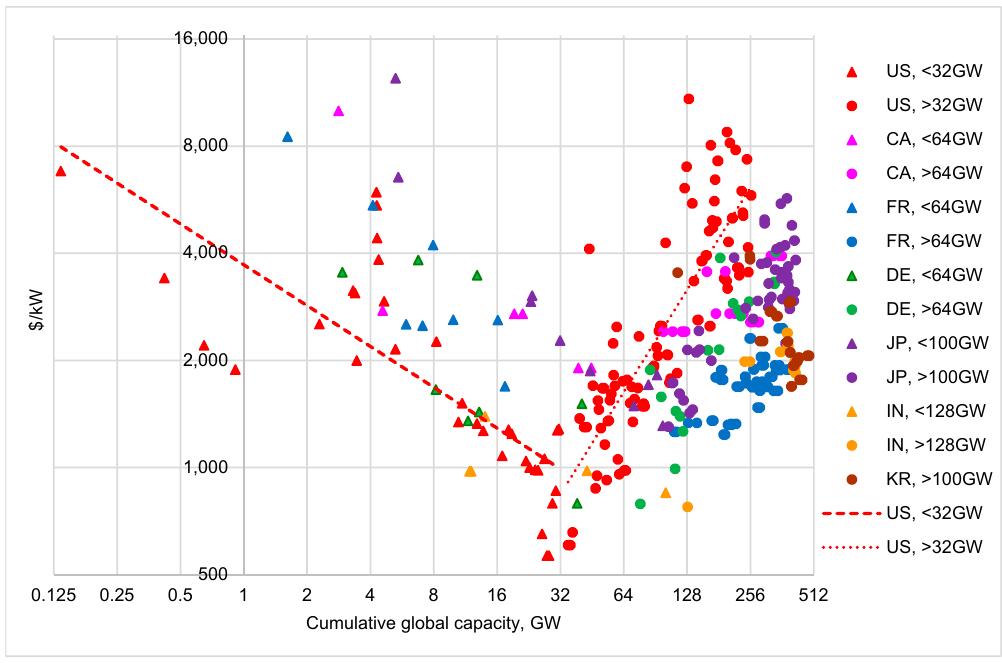
Figure 1. Overnight construction cost (in 2010 US $/kW) plotted against cumulative global capacity (GW), based on construction start dates, of nuclear power reactors for seven countries, including regression lines for US before and after 32 GW cumulative global